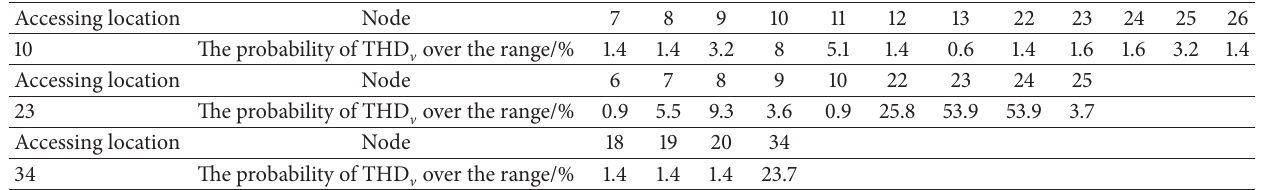
Table 10: The detailed information of THD V over the range in different accessing